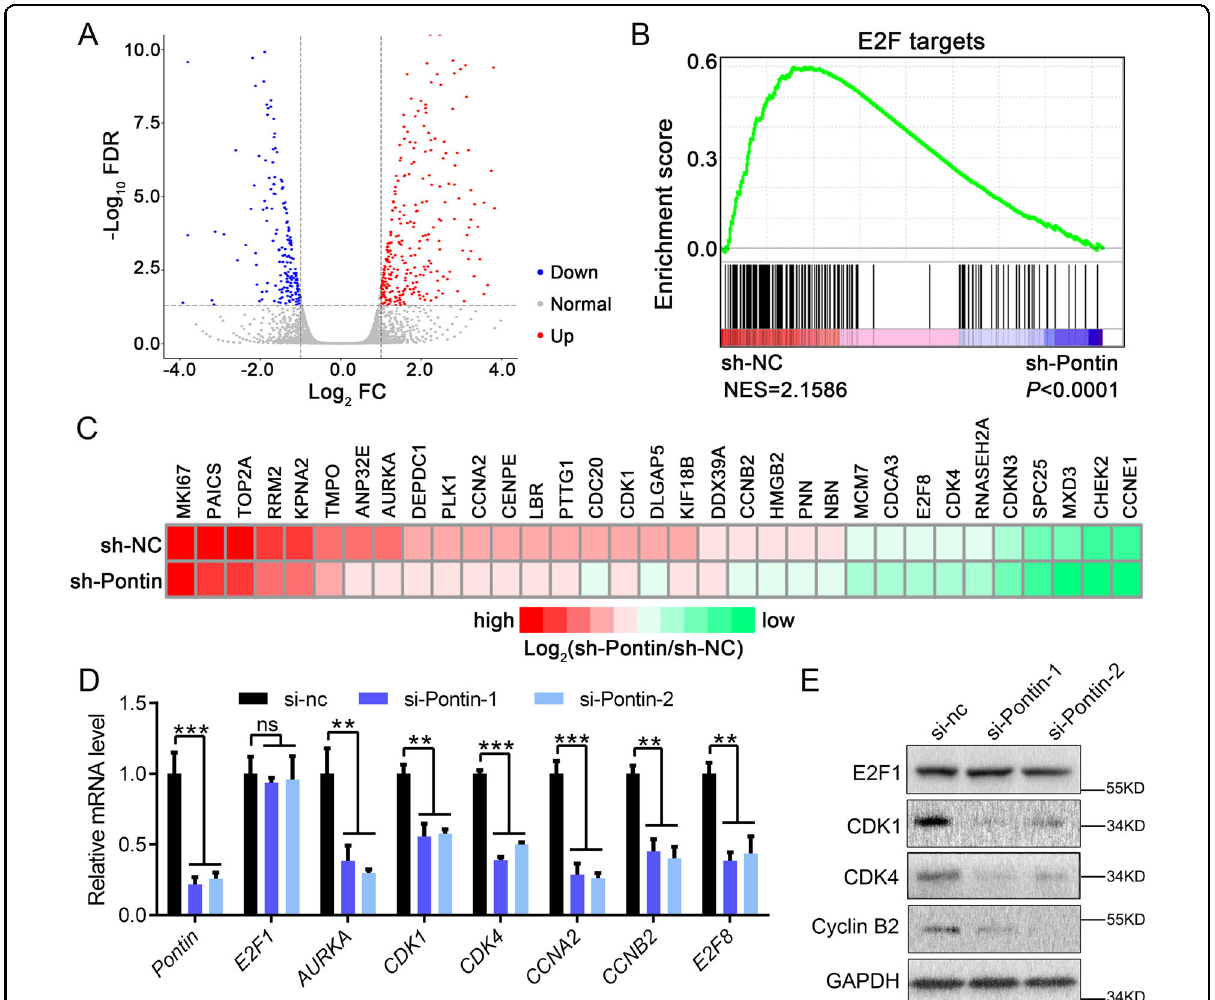
Fig. 4 Pontin knockdown majorly affects the E2F1 transcription response. A Volcano plot for the differential expressed genes affected by Pontin knockdown screened by RNA-seq with FC > 2 and FDR < 0.05. B GSEA plot indicated a signi fi cant correlation between Pontin and E2F target expressions. C Heatmap of the top 33 E2F1 targets expressions in U87MG cells affected by Pontin knockdown. D qRT-PCR detection of Pontin , E2F1 , AURKA , CDK1 , CDK4 , CCNA2 , CCNB2 , and E2F8 expressions in U87MG cells as transfected in Fig. 3A. E Western blot analyses of E2F1, CDK1, CDK4, and Cyclin B2 expressions in U87MG cells as transfected in Fig. 3A. Experiments in ( D ) and ( E ) were performed at least in triplicate. Data in ( D ) are presented as the mean ± SD. ns > 0.05; ** P < 0.01; *** P <